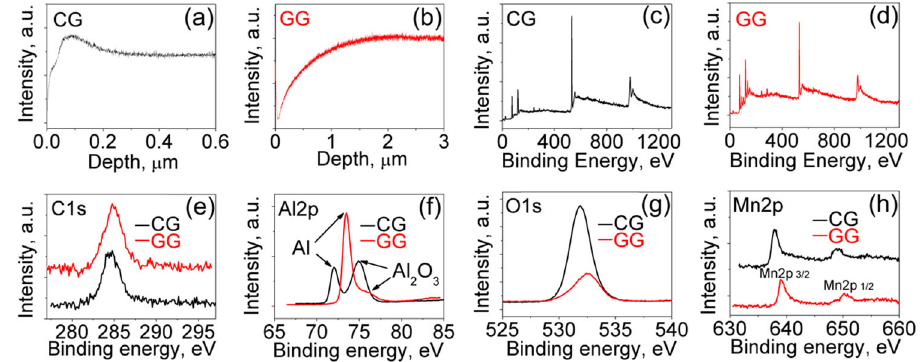
Fig. 5 SIMS Mn pro fi les of Al – 2Mn alloys. a CG sample and b GG sample. XPS survey spectra of c CG and d GG samples, e – h the high- resolution XPS spectra of CG and GG samples: e C1 s ; f Al2 p ; g O1 s ; and h Mn2 p .